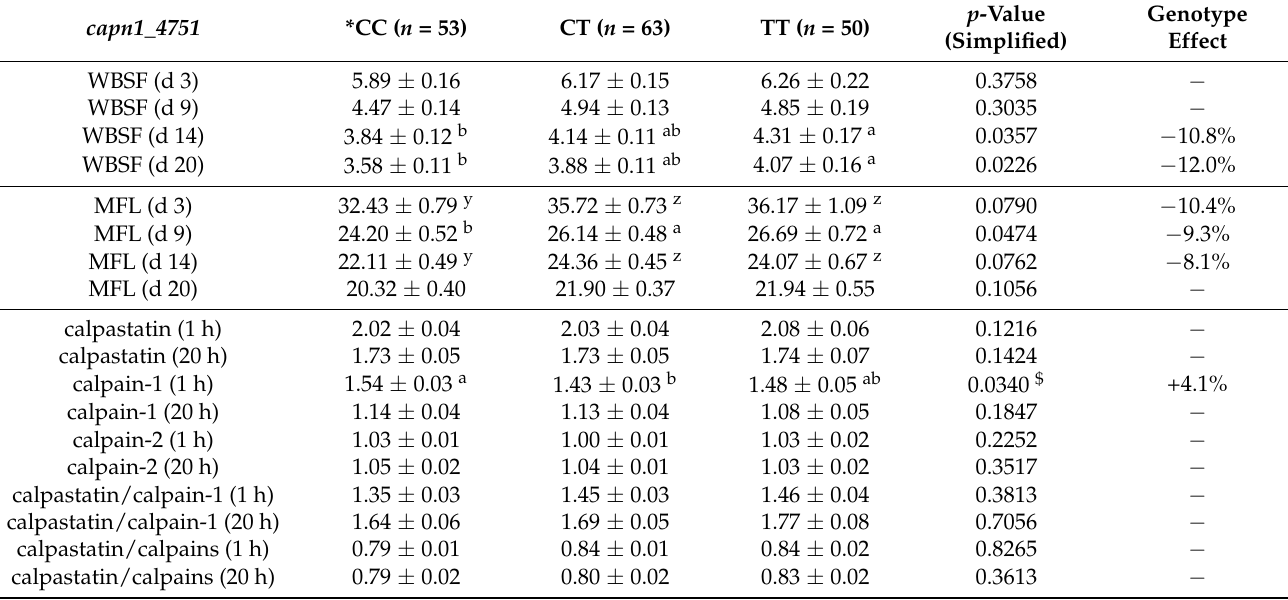
Table 7. The effects of genotype of the capn1_4751 SNP on the tenderness phenotypes, Warner– Bratzler shear force (WBSF) and myofibril fragment length (MFL) of representative purebred South African beef bulls during 3 to 20 days of ageing and on the muscle protease enzyme system during the first 20 h